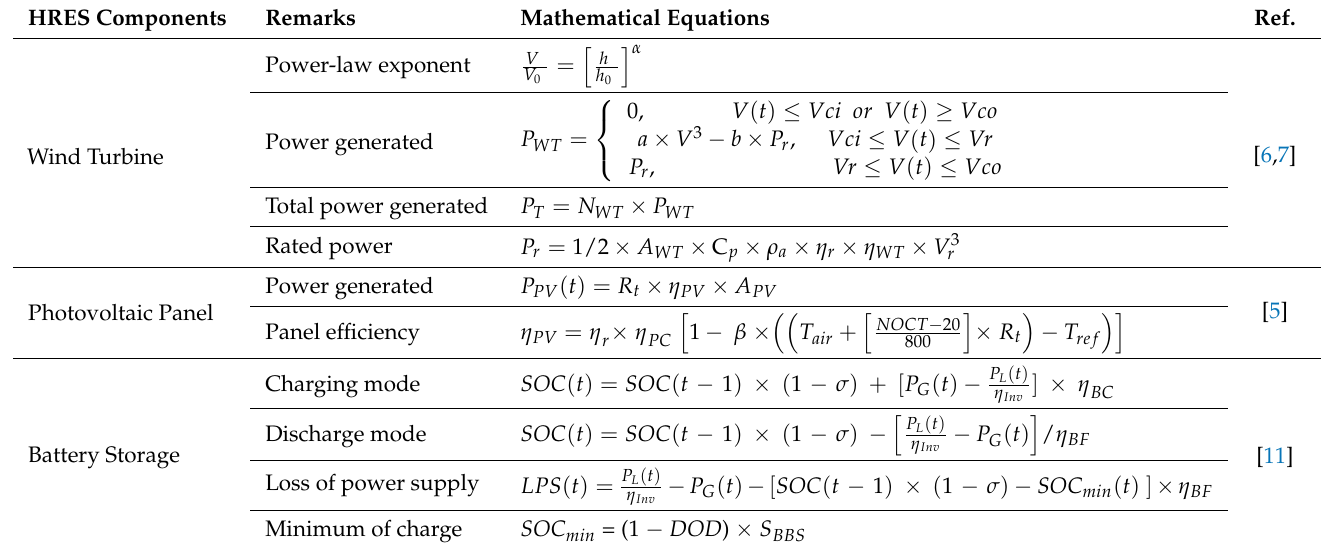
Table 1. A summary of the PV/WT hybrid microgrid components’ mathematical